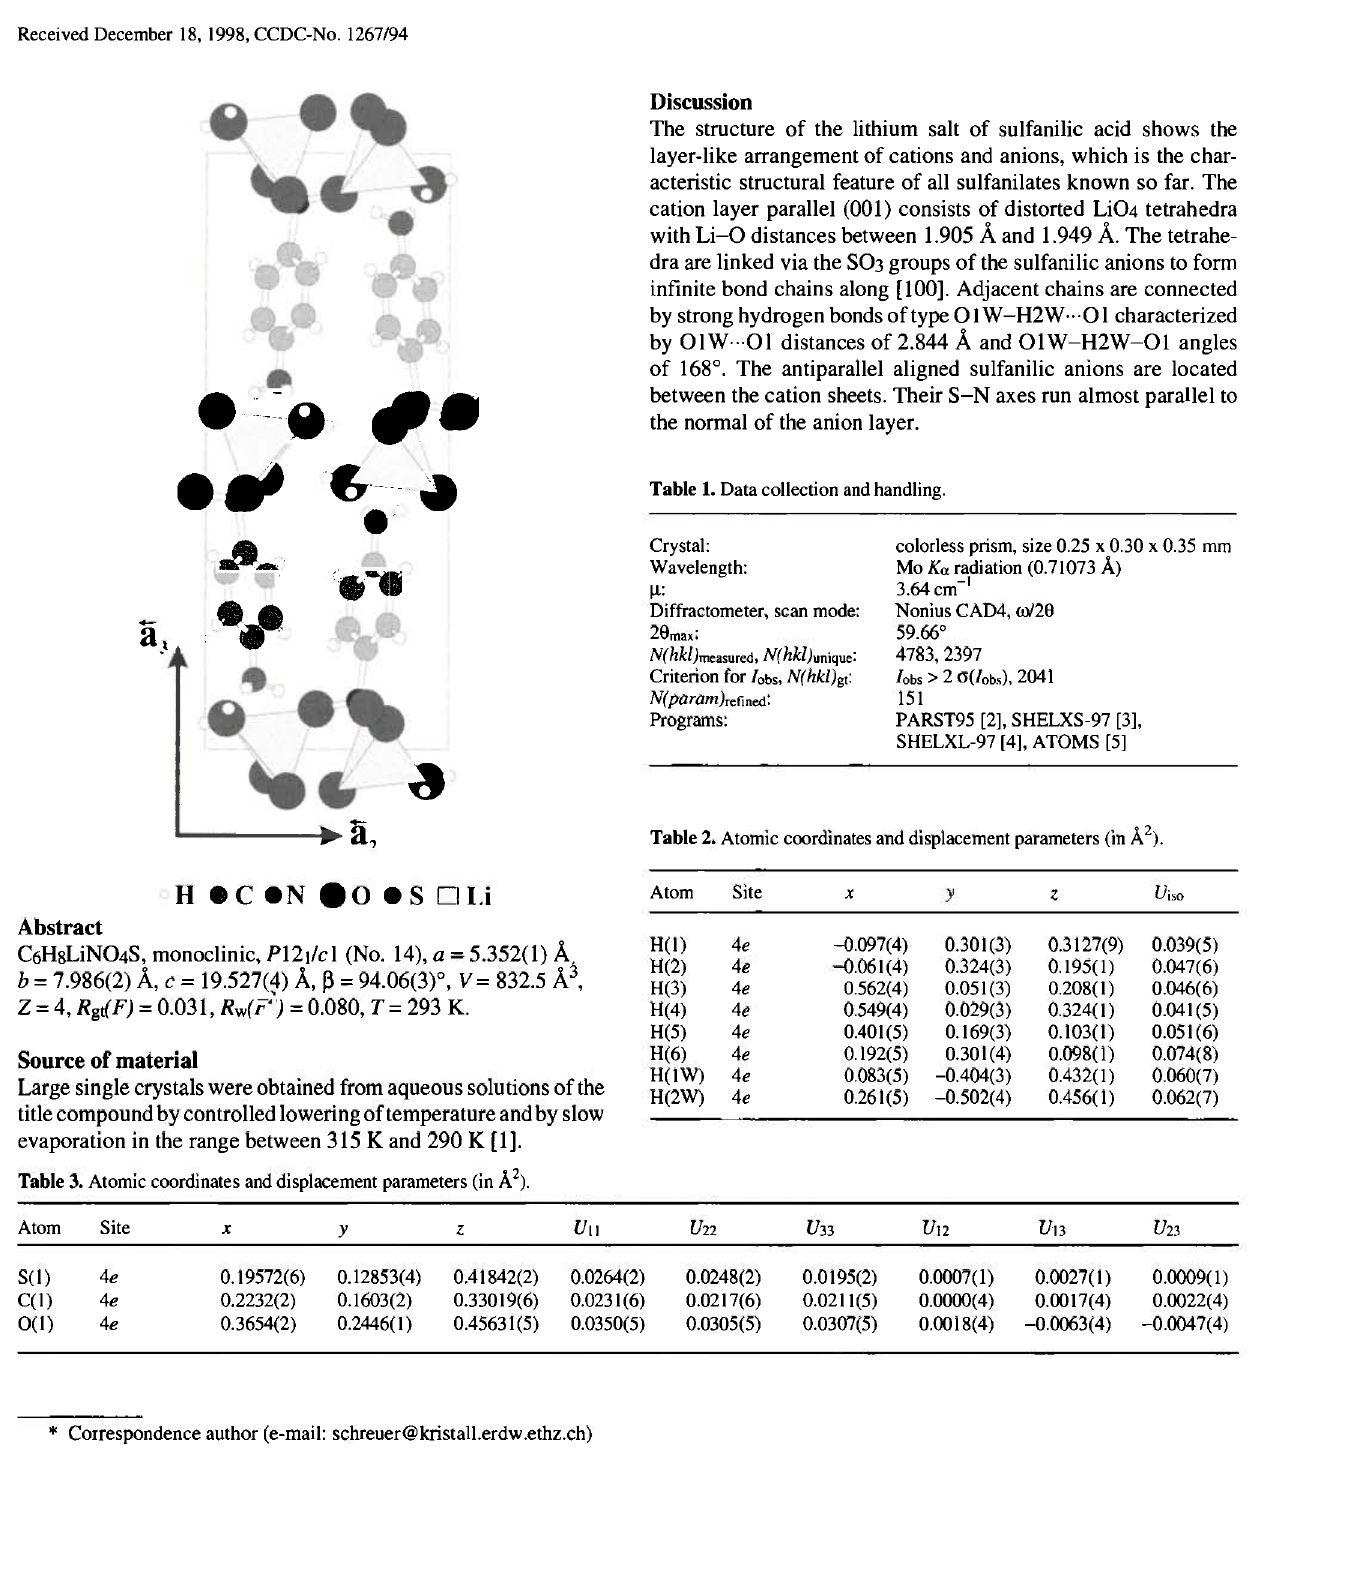
Table 1. Data collection and handling.